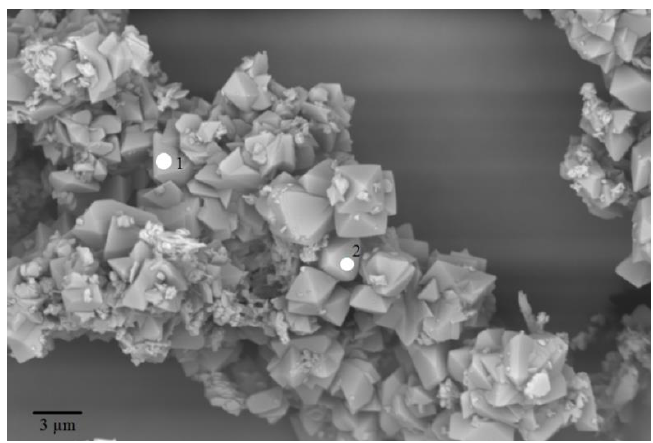
Figure 11. SEM of the leaching residue at 123 °C, with HF (15% v/v)–H 2 SO 4 (10% v/v).